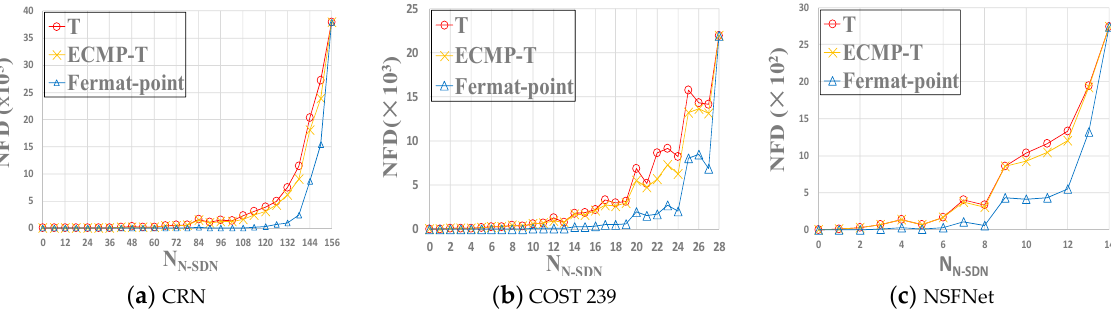
Figure 11. The impact of SDN interception models on NFD under three topologies. NFD. The lower, the better.